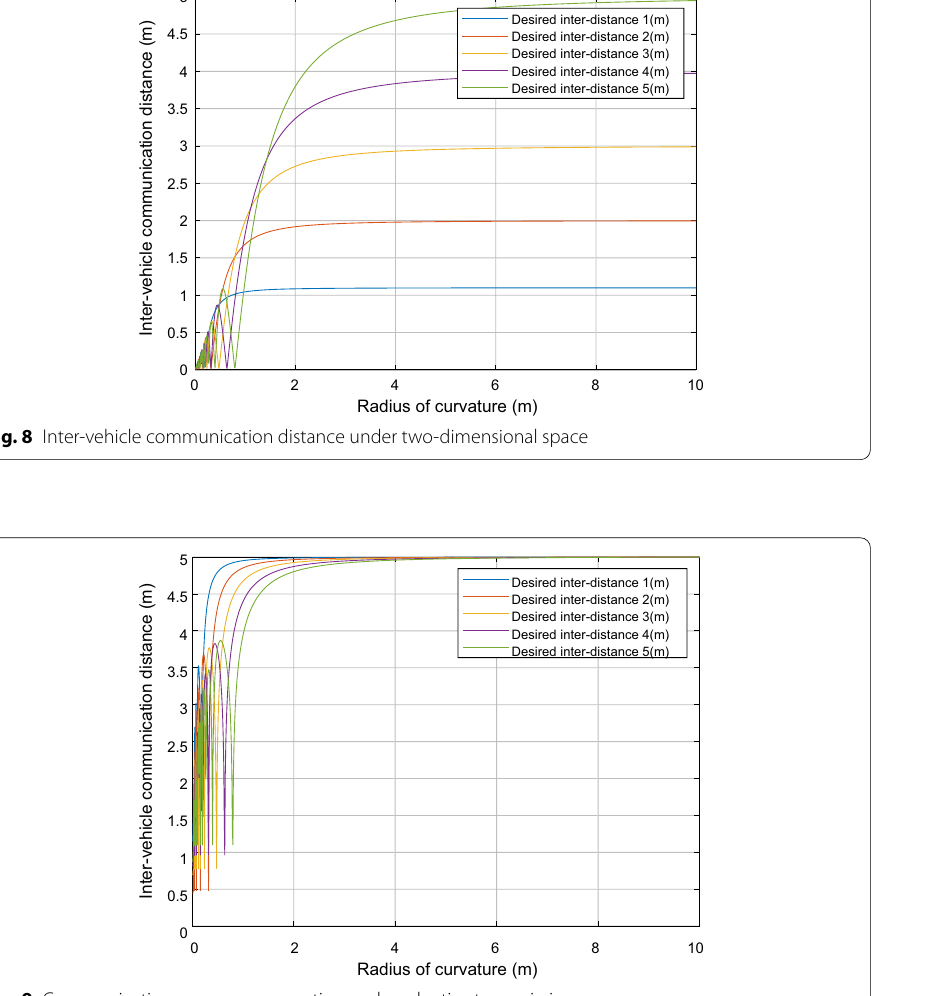
Fig. 9 Communication energy consumption under adaptive transmission